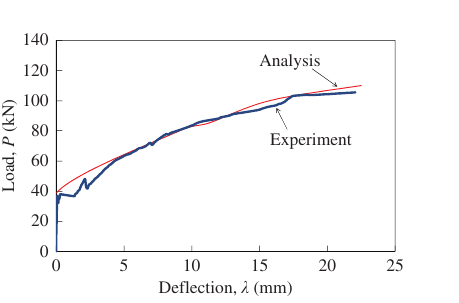
Figure 11 Comparison of experiment with analysis (Below rein- forced concrete).